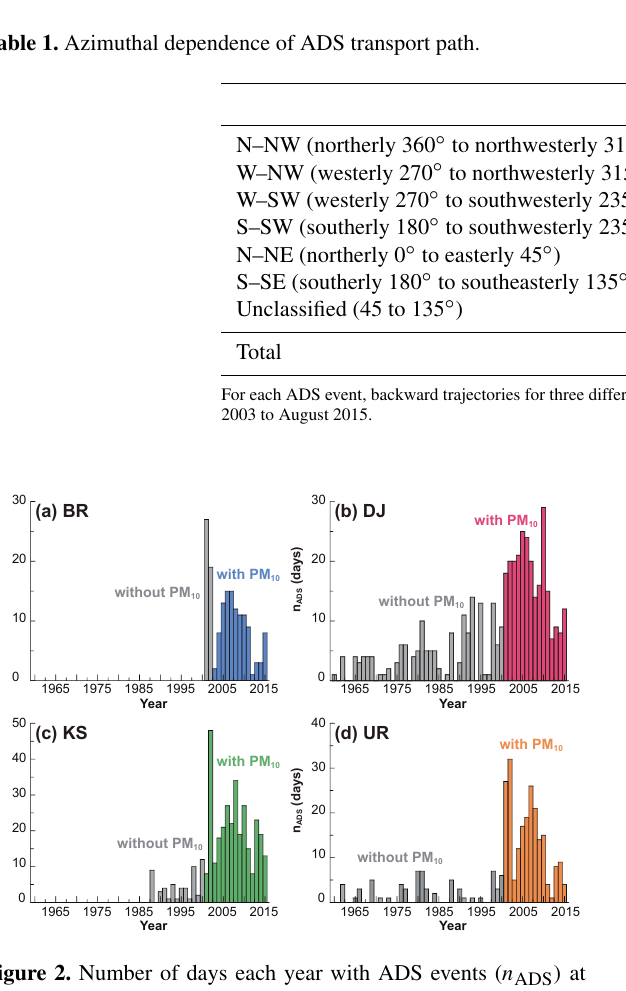
Figure 2. Number of days each year with ADS events ( n ADS ) at (a) BR, (b) DJ, (c) KS, (d) UR. Modern data set includes the PM 10 observations.